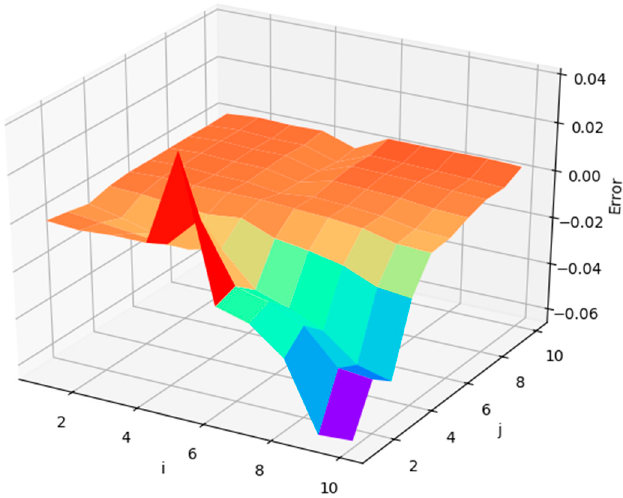
Figure 9. Changes of relative error between original data and filling data with the variations of i and j .